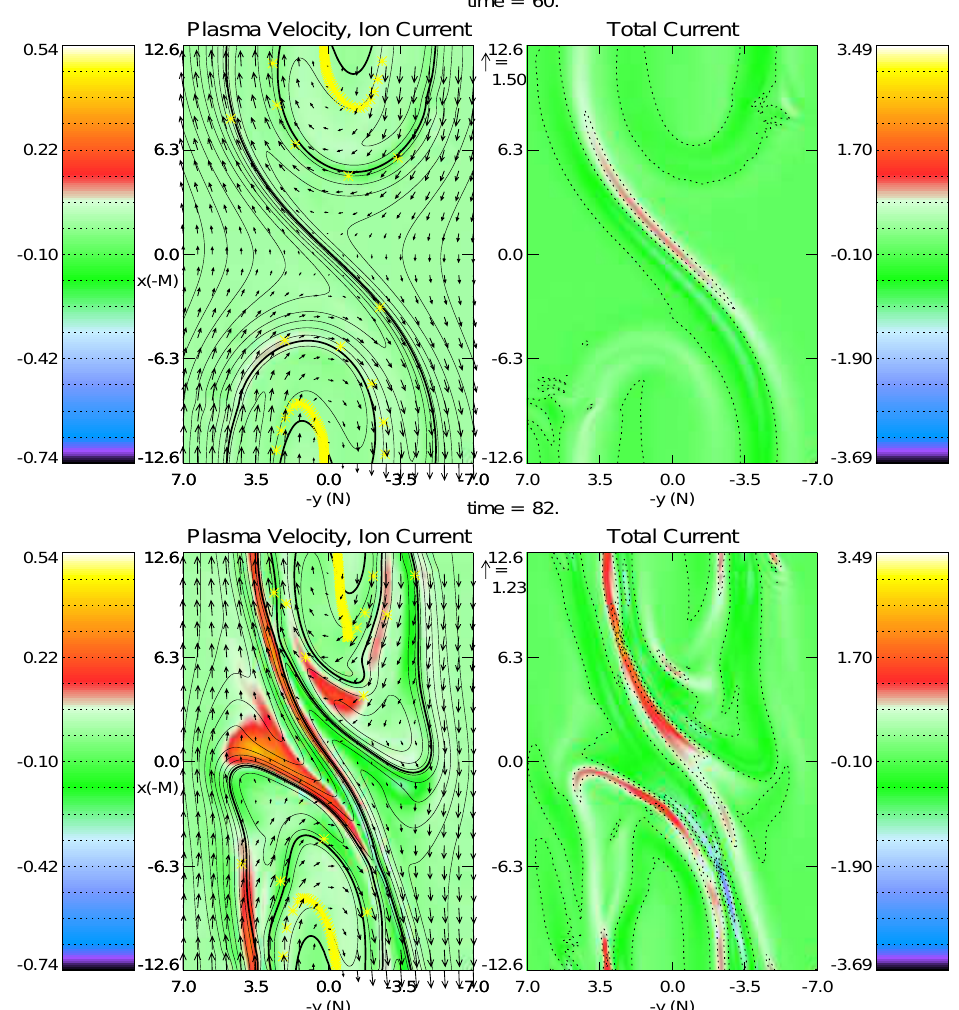
Fig. 2. KH vortex at t/τ A ≈ 60 and at t/τ A ≈ 82. Lines are magnetic field lines projected to x,y -plane and arrows are plasma velocity vectors. Color code represents ion current (left) and total current